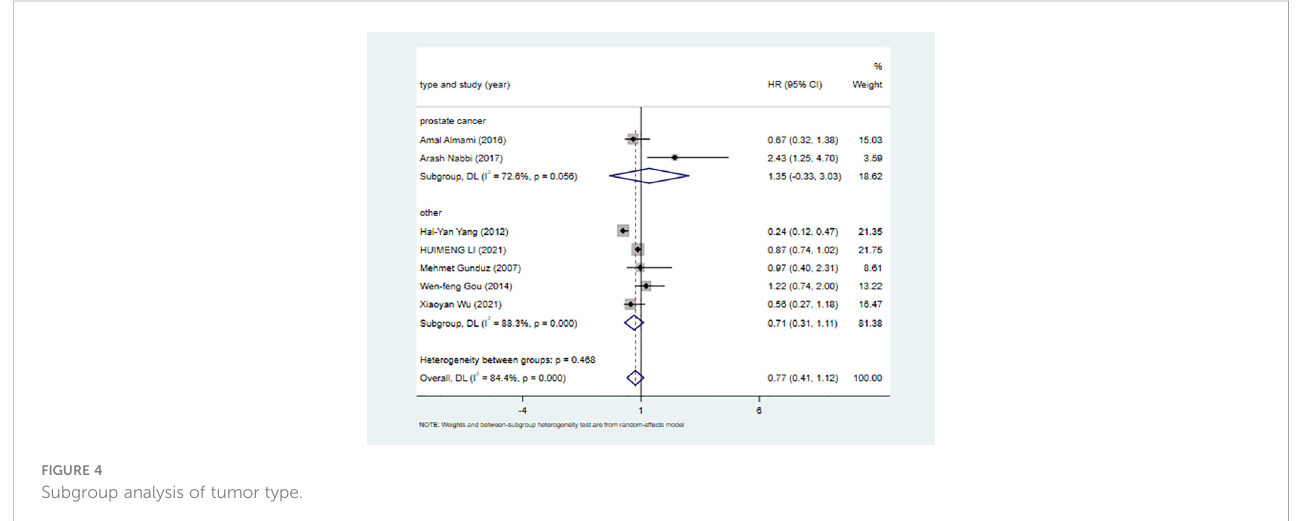
FIGURE 4 Subgroup analysis of tumor